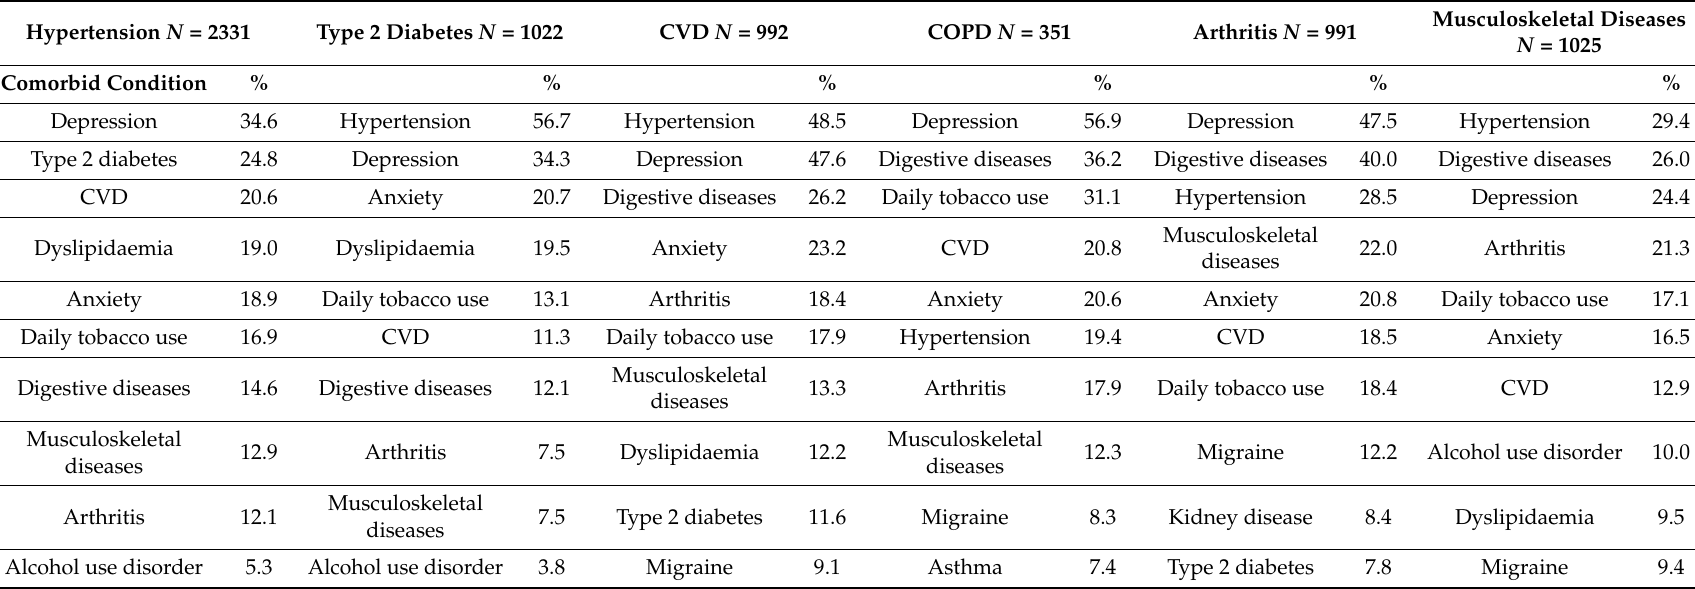
Table 2. The top ten chronic conditions that were comorbid with each chronic condition. COPD: chronic obstructive pulmonary